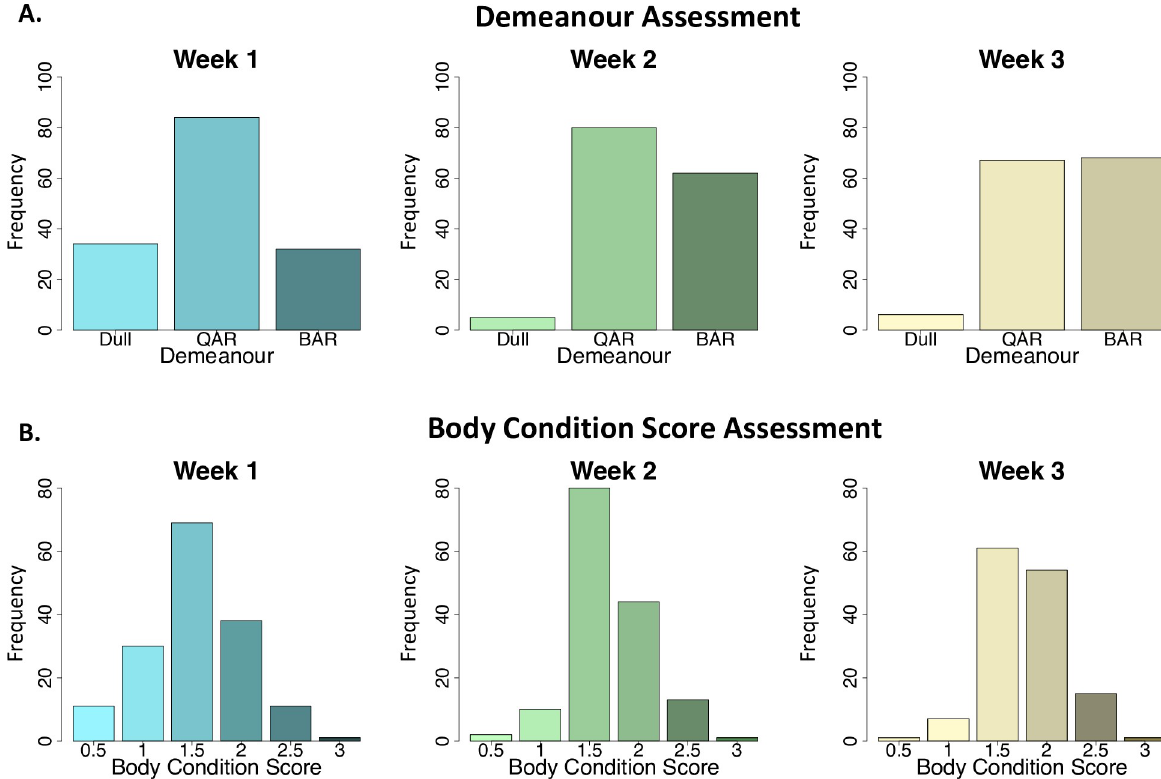
Fig 2. Bar plots illustrating categorisation of subjective parameters for the treatment trial population (n = 162). Demeanour (A) and body condition score (B) were evaluated during the initial examination (week 1) and follow up post-treatment evaluations (weeks 2 and 3). Number of individuals (frequency) is plotted on the y-axis in each case. Bar plots represent the whole treatment trial population at each time point (week 1, week 2 and week 3). Demeanour (A) was assessed as BAR (bright, alert and responsive), QAR (quiet, alert and responsive) or dull. Assessed demeanour improved following treatment (week 1 to week 2) (p < 0.001). Body condition (B) score (0-5/5) improved following trypanocidal treatment (p =